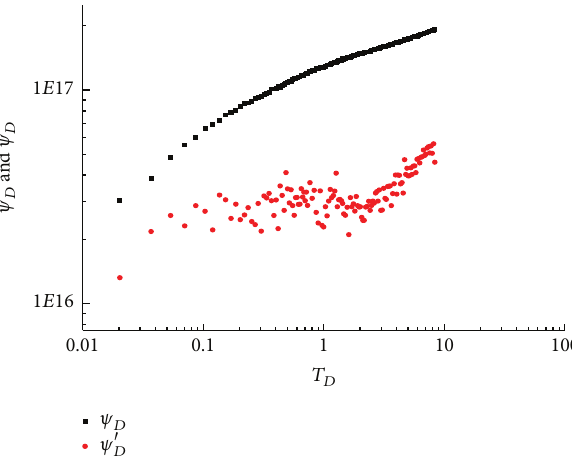
Figure 4: Double logarithmic curve of pressure drop of test